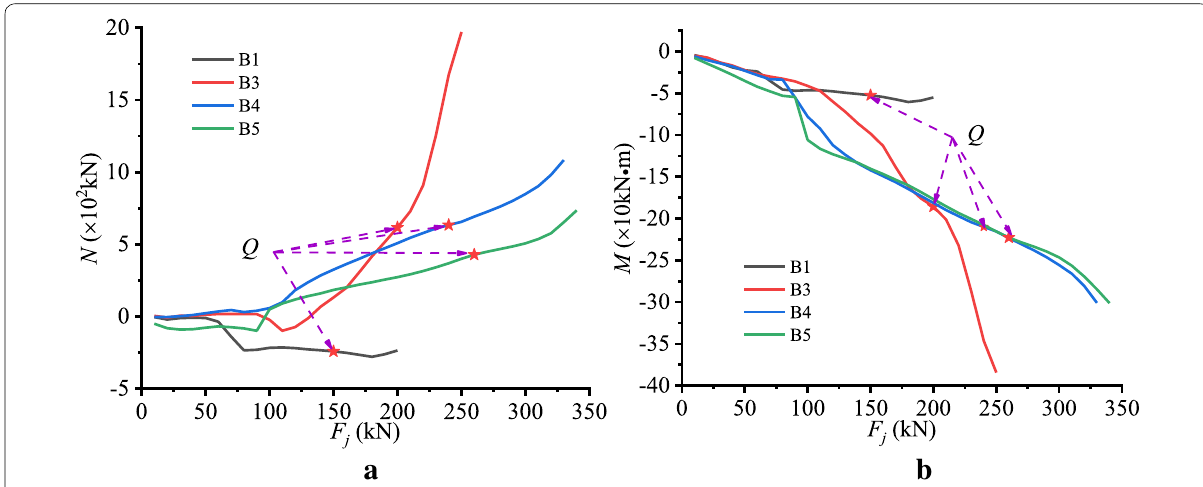
Fig. 20 The internal forces of the different RC beams: a the bending moments of the RC beams with different reinforcement ratio; b the axial forces of the RC beams with different reinforcement